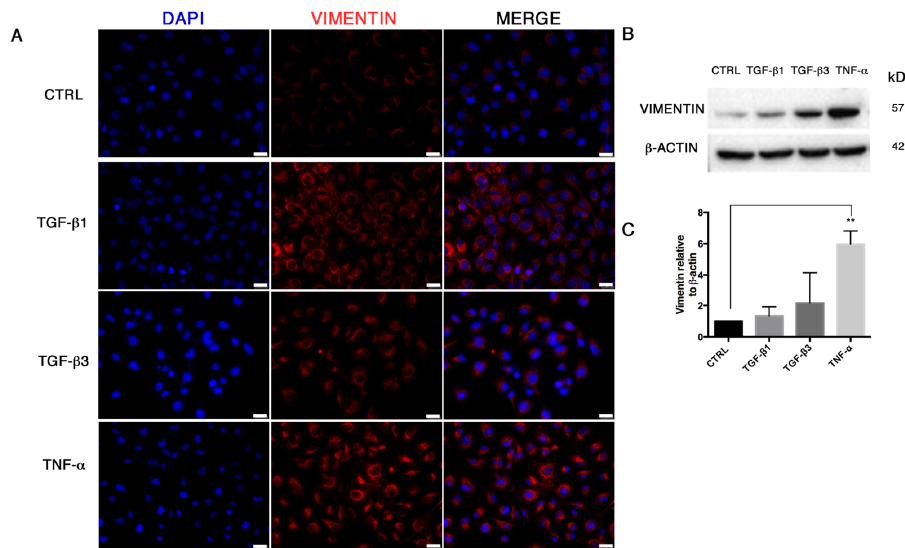
Figure 2. VIMENTIN expression in HUVECs during End–MT. ( A ) Immunofluorescence of VIMENTIN (red cytoplasmic extension, 40× magnification) in HUVECs after 24 h exposure to TGF- β 1, TGF- β 3 and TNF- α . Scale bars = 25 μ m. ( B ) VIMENTIN detection in whole cell lysates assessed by Western Blot and ( C ) relative quantification to β -actin,